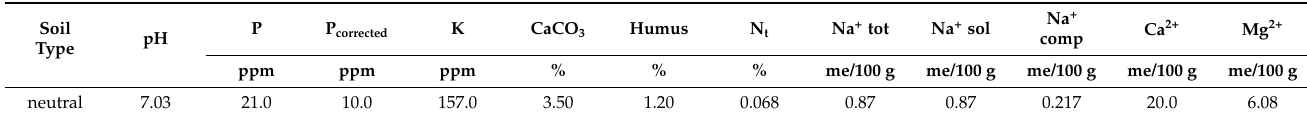
Table 4. Neutral field results (control